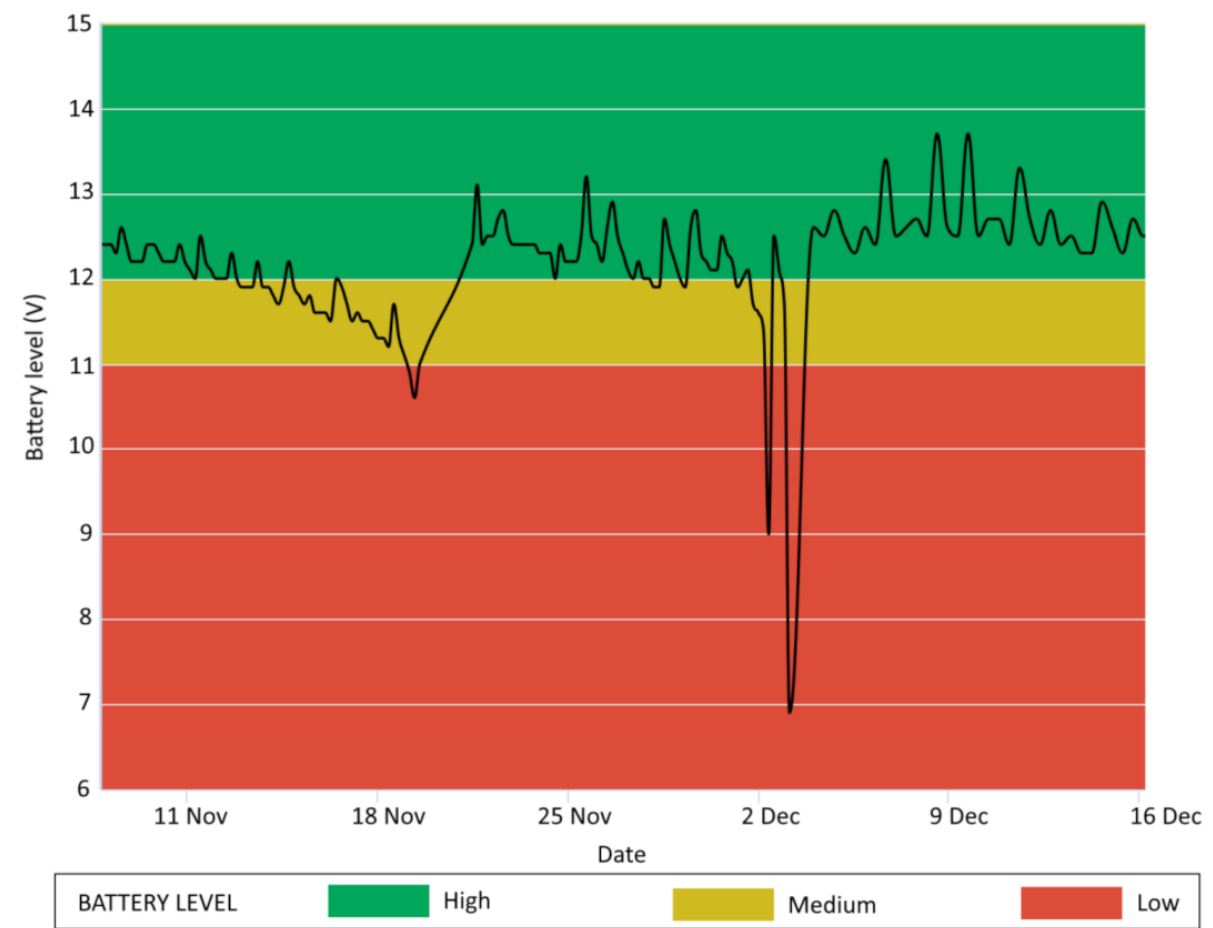
Figure 3. Battery voltage monitoring over time, with three different charge